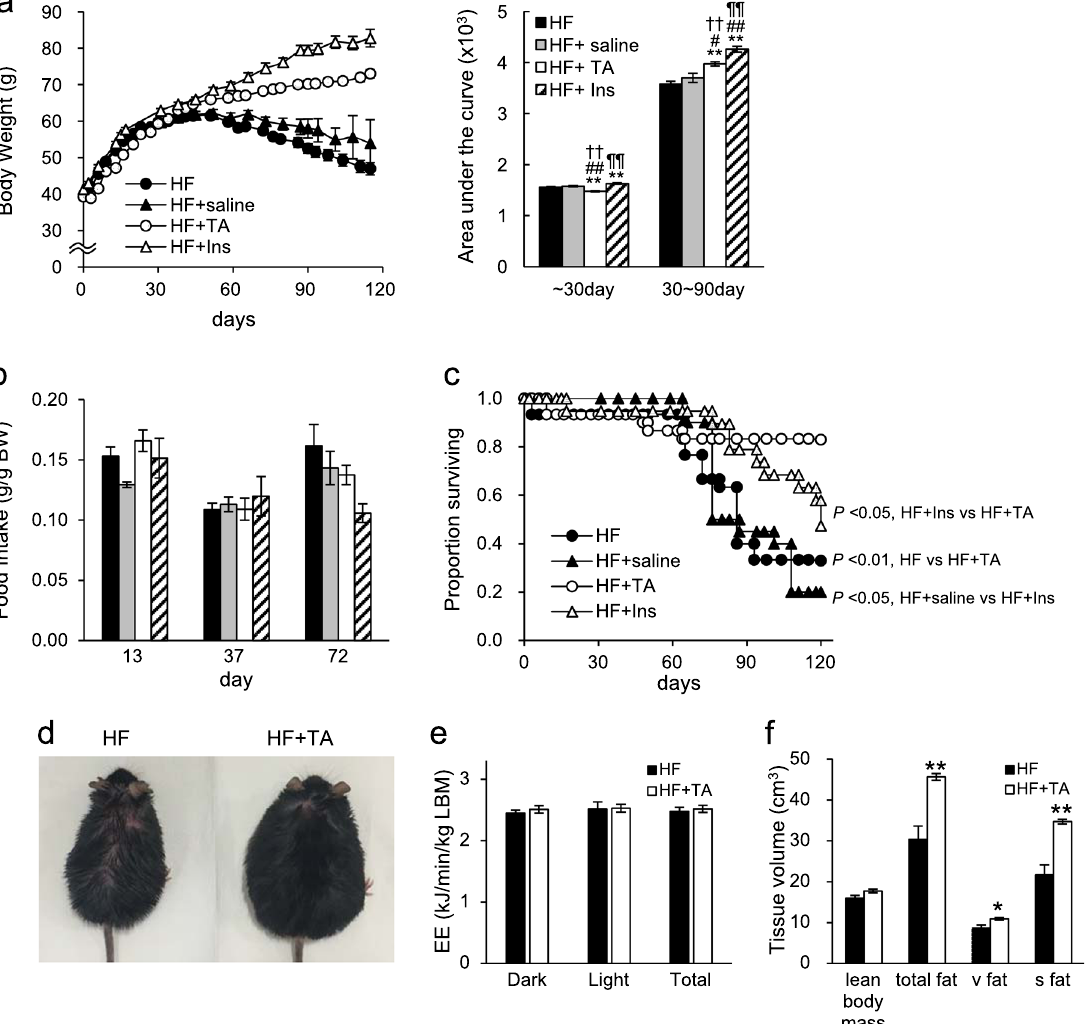
Fig. 1 TA-1887-treated or insulin-treated severely diabetic mice show enhanced survival and increased body weight but does not alter food intake or energy expenditure. a left: Changes in body weight in db/db mice fed a high-fat diet (HF) or comparable mice treated with saline (HF + saline) or with TA-1887(HF + TA) or insulin (HF + Ins) ( n = 20 – 30). right: AUC for body weight at indicated periods. b Food intake of each group at 13, 37, and 72 days ( n = 6). c Proportion of animals surviving 4 months ( n = 20 – 30). d Representative appearance of mice in indicated groups at day 80. e Energy expenditure (EE) after 9 weeks of each treatment, as determined by indirect calorimetry ( n = 6). f Volume of lean body mass, total fat, visceral fat (v fat) and subcutaneous fat (s fat), as measured by computed tomography (CT) after 3 months of each treatment ( n = 6). Values shown are means ± SEM. * p < 0.05, ** p < 0.01 versus HF, and # p < 0.05, ## p < 0.01 versus HF + saline, and ¶¶ p < 0.01 versus HF + TA and †† p < 0.01 versus HF +